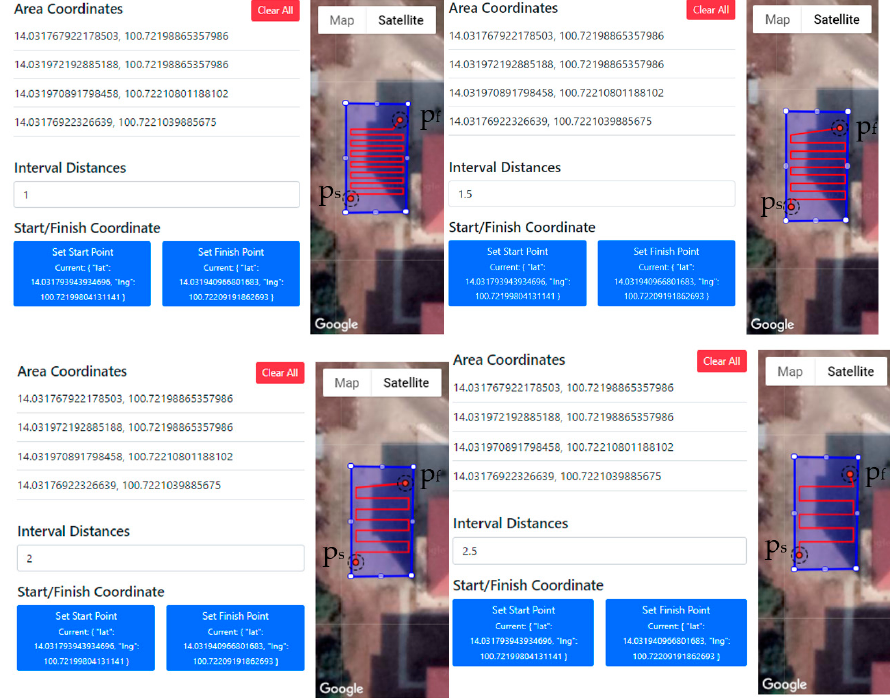
Figure 8. Path planning platform implementation using Laravel and Google Maps.